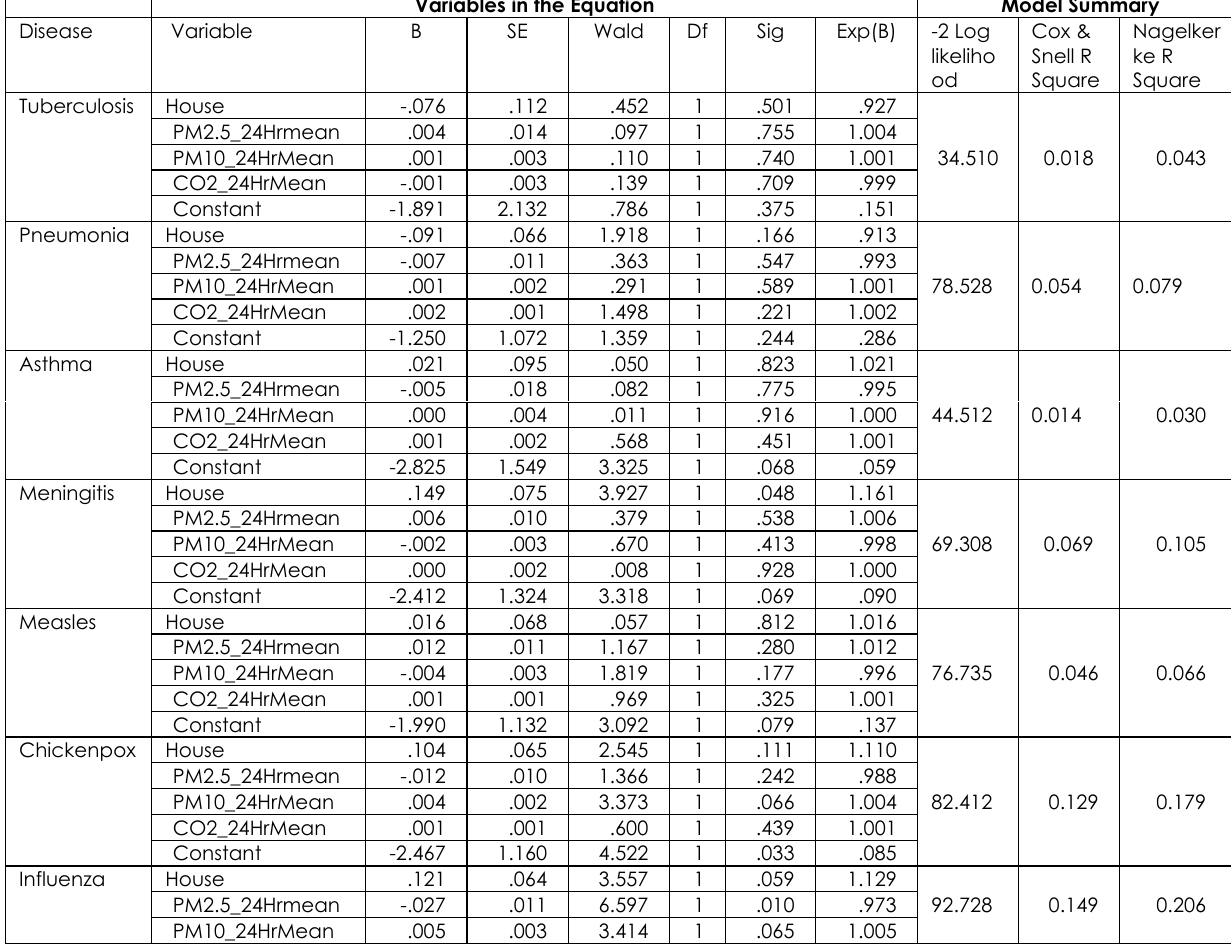
Table 2. Susceptibility to ill-health based on indoor CO 2 and PM 10 /PM 2.5. Variables in the